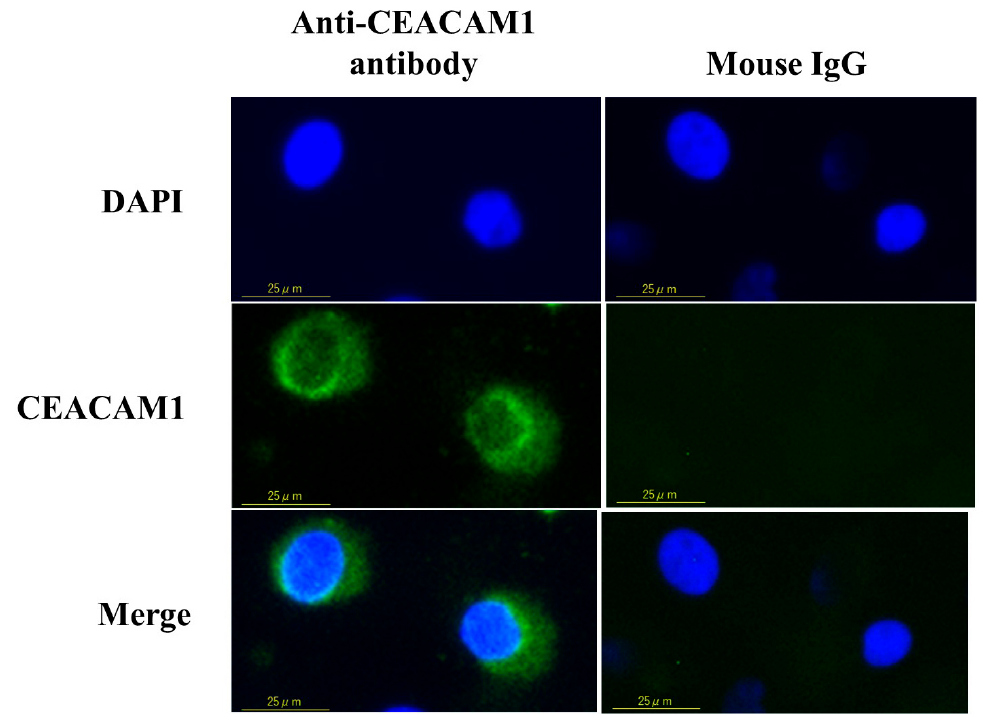
Figure 1- Expression of CEACAM1 in oral keratinocytes and fibroblasts Localization of CEACAM1 expression in RT7 cells. Cells were stained with anti-CEACAM1 or mouse IgG as a negative control along with Alexa Fluor ® 488 conjugated mouse IgG, and nuclei were counter-stained with DAPI (blue). Green staining indicates CEACAM1. Each experiment was performed at least three times, with representative results